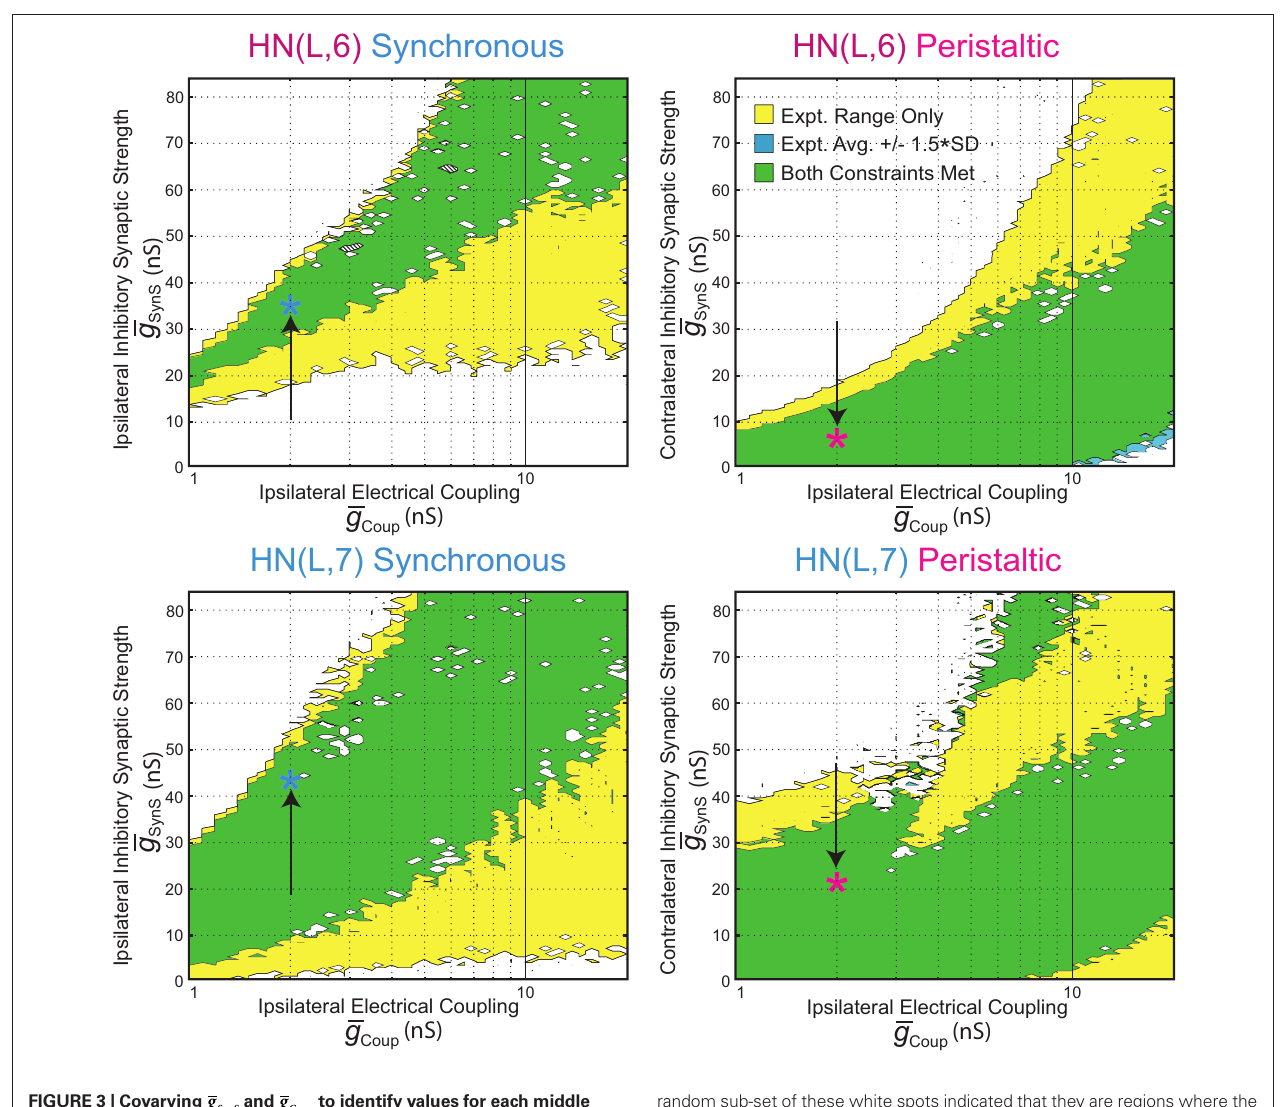
Figure 3 | Covarying g SynS and g Coup to identify values for each middle premotor interneuron ipsilateral (left/synchronous) and contralateral (right/peristaltic) to the active (left/synchronous) HN(5) interneuron for which the model gave phasing and duty cycle appropriate to the living system. For every combination of g SynS and g Coup , phase and duty cycle for that middle premotor interneuron were calculated and compared with that individual neuron’s experimentally recorded values (Norris et al., 2006). Two criteria were applied for displaying the data. If the model data fell within the experimental data range, it is indicated as a yellow region. If it fell within the experimental average ± 1.5 × SD, it is indicated as a blue region. If both criteria were met, the regions were shown in green. If neither criterion was met, then the region was left blank. There are several small blank regions (white spots) inside regions where otherwise both criteria were met. Investigation of a